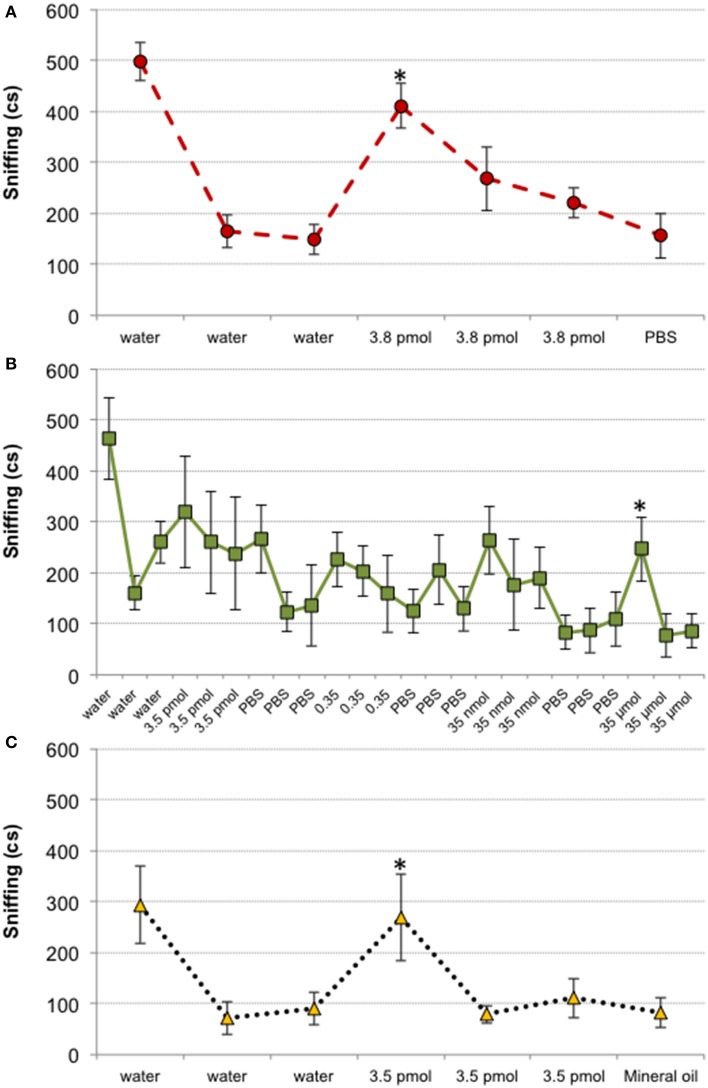
Mice are able to detect TMT, 2-HP and IA in habituation–dishabituation tests. Line charts representing the chemoinvestigation of scented cotton swabs in cs. 3.8 pmol of TMT elicited increased chemoinvestigation (A), whereas 2-HP did not significantly increase chemoinvestigation until we presented 35 μmol (B). The detection threshold of IA was similar to that of TMT (C). Comparison between last presentation of a solvent (water, PBS with Triton X-100 1% or mineral oil) and first presentation of each odorant amount, *p < 0.05. Data are expressed as mean ± SEM.